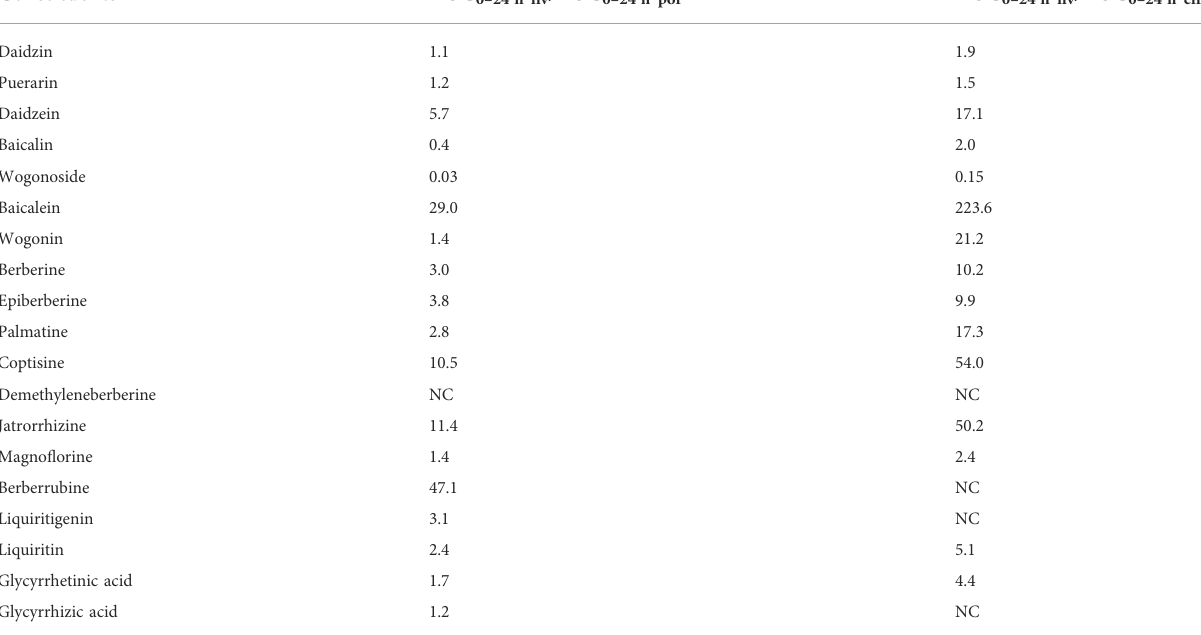
TABLE7ComparisonoftheAUC 0 – 24 h valuesofthemajorconstituentsof Gegen - Qinlian decoctioninthelivers(AUC 0 – 24 hliv) withthoseintheblood of portal vein (AUC 0 – 24 h por ) or systemic circulation (AUC 0 – 24 h cir ).